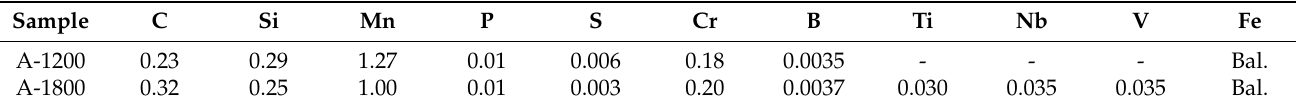
Table 1. Chemical compositions of hot-stamped steels